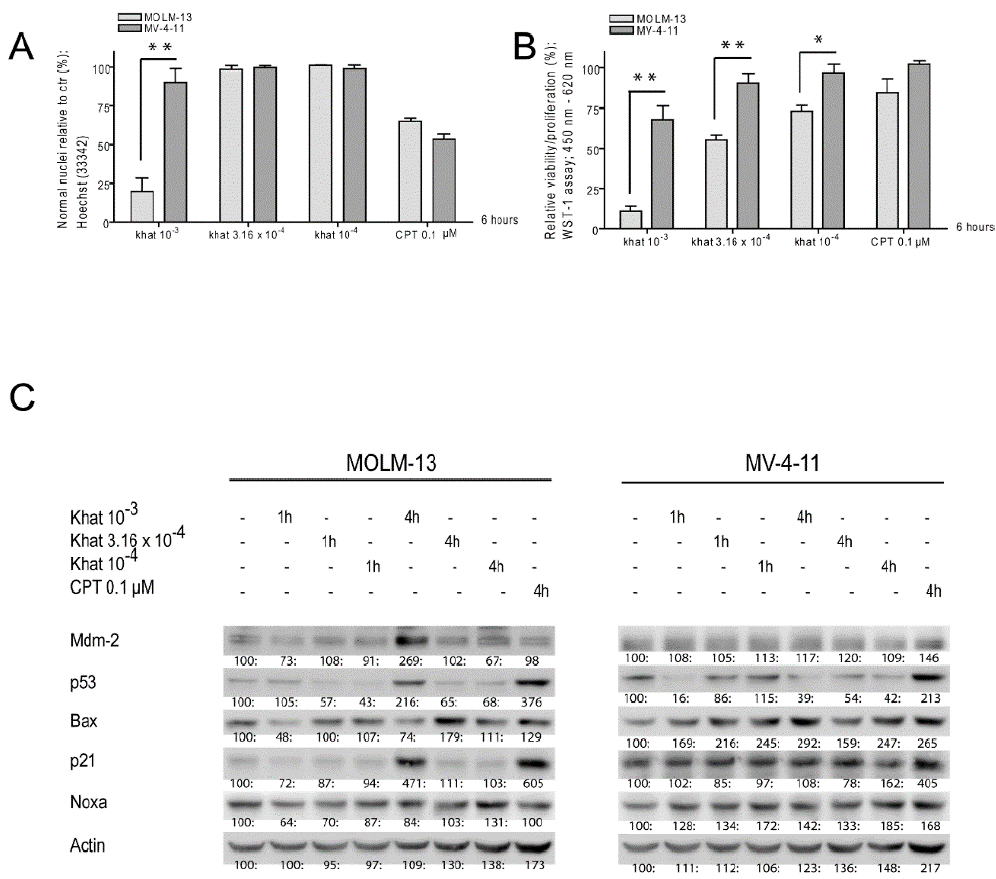
Figure 1. Induction of p53 and transcriptional targets in khat-sensitive MOLM-13 cells. MOLM-13 and MV-4-11 were exposed to khat-extract dilutions of 10 –3 , 3.16 × 10 –4 and 10 –4 , and to 0.1 µ M camptothecin (CPT). ( A ) Effects on nuclear morphology were evaluated after 6 h following Hoechst staining using epifluorescent microscopy. The results are presented as percentages of cells with normal nuclear morphology as compared to controls. The experiments were run in triplicates and repeated three times. The asterisks represent levels of statistical significance, with ** = p ≤ 0.01. ( B ) Effects on cell viability/proliferation were assessed after 6 h using the WST-1 assay. The results were collected by measuring absorbance (450 – 620 nm) and are presented as: [(absorbance treated cells)/(absorbance control cells)] × 100. The experiments were run in triplicates and repeated three times. The asterisks represent levels of statistical significance, with * = p ≤ 0.05 and ** = p ≤ 0.01. ( C ) Alterations in levels of p53 and p53 target proteins were evaluated after 1 and 4 h by one-dimensional polyacrylamide gel electrophoresis (1D-PAGE) and Western blot (original blots can be found at Figure S1) . β -actin was used as loading control. The intensity of each band was evaluated using the ImageJ software, and are presented as a ratio: [(intensity of treated sample) / (intensity of control sample)] × 100. The experiments were repeated three times.